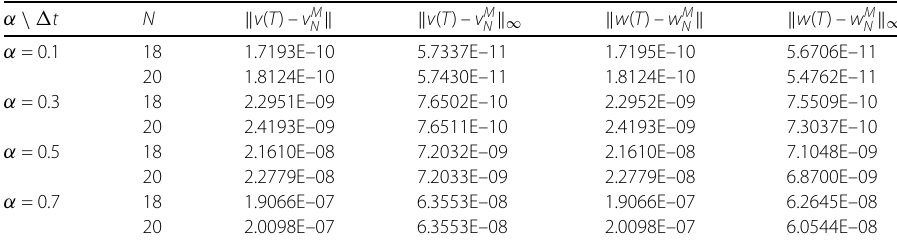
Table 6 L 2 , L ∞ errors of v and w at (cid:2) t = 10 –4 for Example